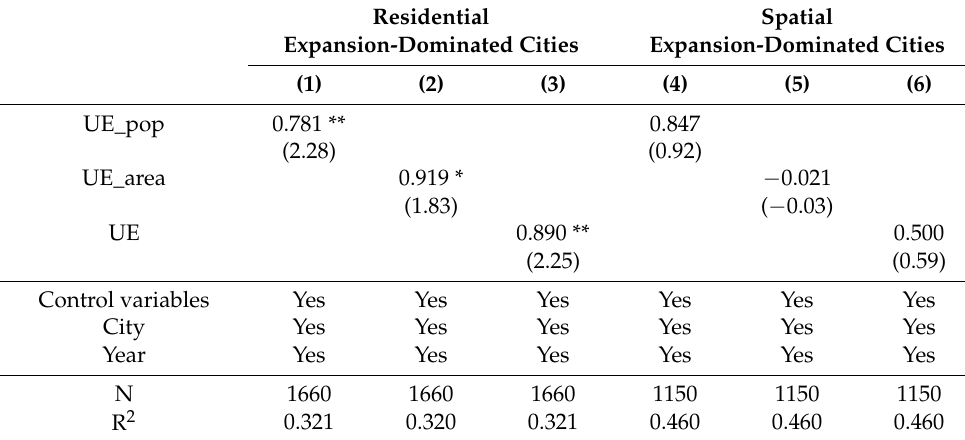
Table 7. Regression results of heterogeneity of urban expansion modes.